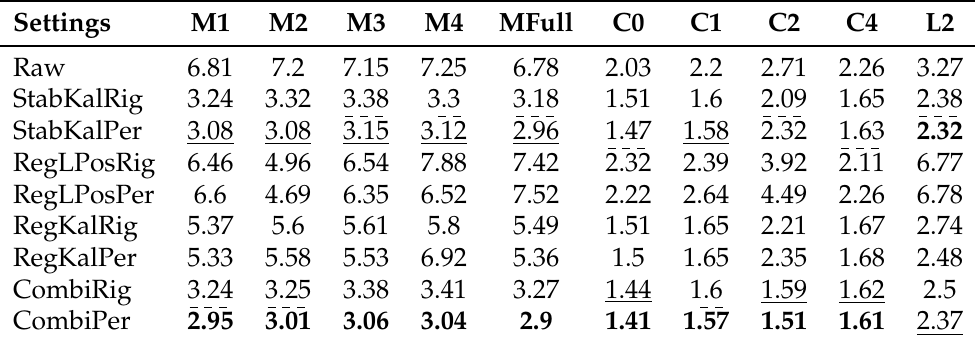
Table 2. Mean pixel value difference ( mpvd ) between consecutive frames (grayscale value). First rank ; Second rank; Third rank. Higher values tend to be caused by jitter while lower values show the stability properties.